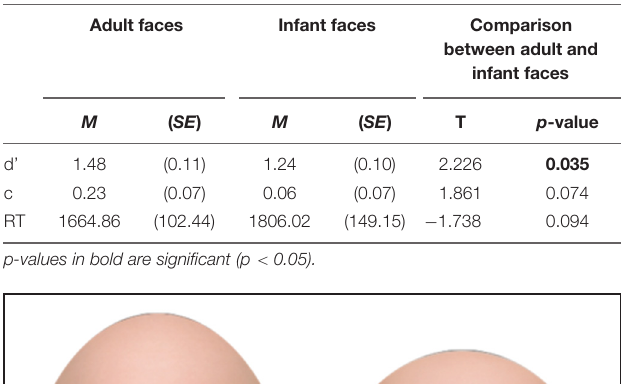
TABLE 1 | Behavioral performance measures: means and SE of sensitivity index (d’), response bias (c), mean correct response times (RTs) in milliseconds for adult and infant faces.